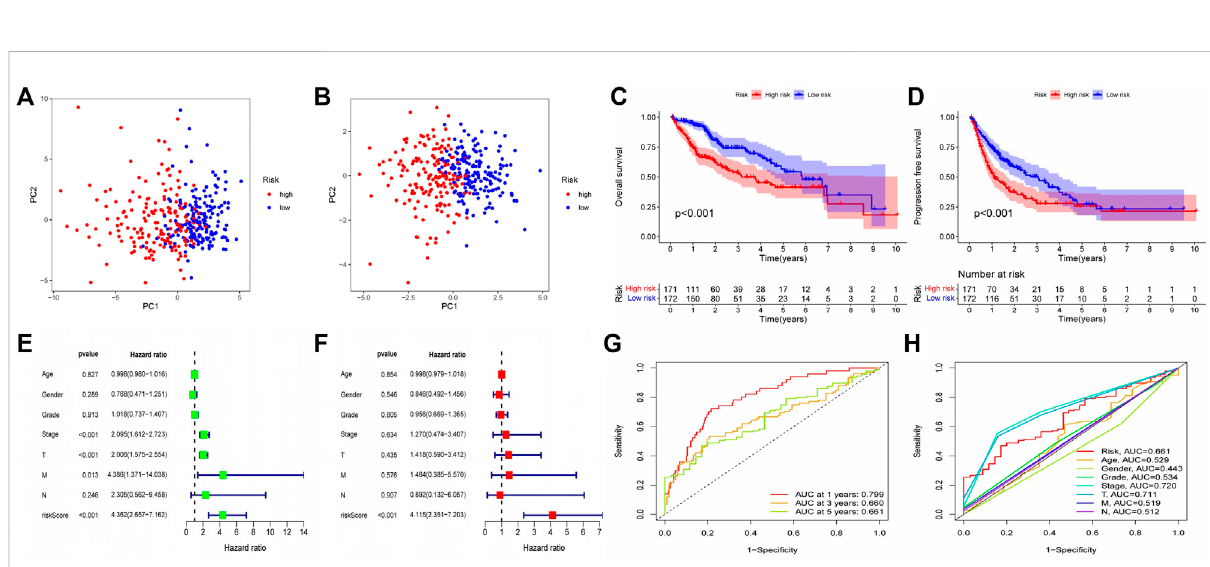
FIGURE 5 Validation of Prognostic Model Reliability by Several Methods (A – B) PCA analysis showed that patients with different risk scores could be well distinguished in the model. Blue points represented low risk group, and red points represented high risk score group; (A) training set (TCGA cohort). (B) validationset(GEOcohort) (C – D) SurvivalanalysisbasedonKaplan-Meiermethodwasperformedonthetotalsurvivaltimeandprogression-free survival time of patients with different risk scores. The horizontal axis under the image refers to the number of surviving patients in different years; (C) training set (TCGA cohort). (D) validation set (GEO cohort) (E – F) The prognostic model and common clinical features were analyzed by univariateor multivariate COX regression.HR valuerepresents that theprobability of death in thehigh-risk group per unit time was amultiple